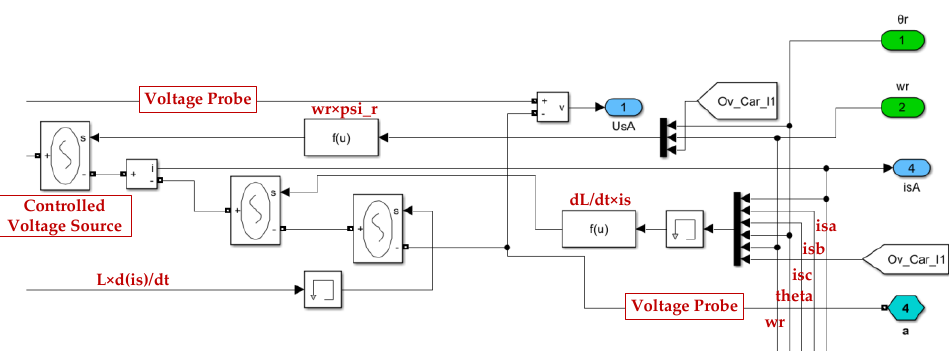
Figure 7. Part B of the motor model.